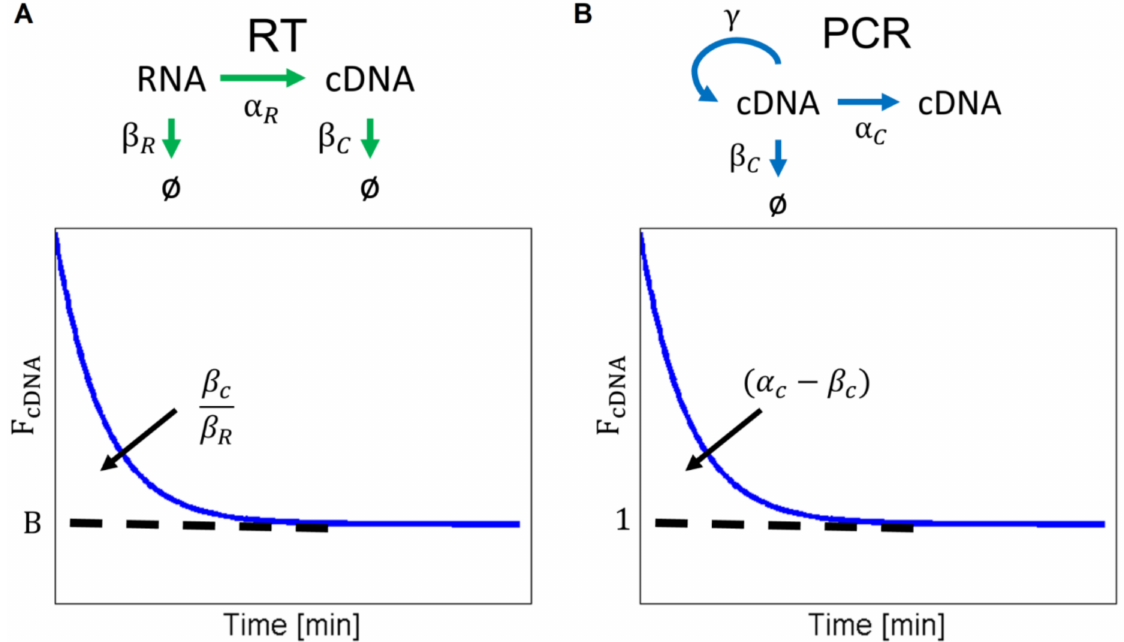
Figure 6. ( A ) Fano factor of the cDNA copies (F cDNA ) for the RT phase as described by Equation (10). The discontinuous line represents the asymptotic value proportional to 1/ ( β r + β c ) . The arrow indicates the increase in the decay speed as the ratio of the degradation rates ( β c / β r ) increases. ( B ) F cDNA time dynamics for the PCR phase described by Equation (11). The decay speed decreases as the difference in the cDNA replication rate and degradation rate ( α c − β c ) increases (arrow). The used parameters to draw the F cDNA dynamics are in Table